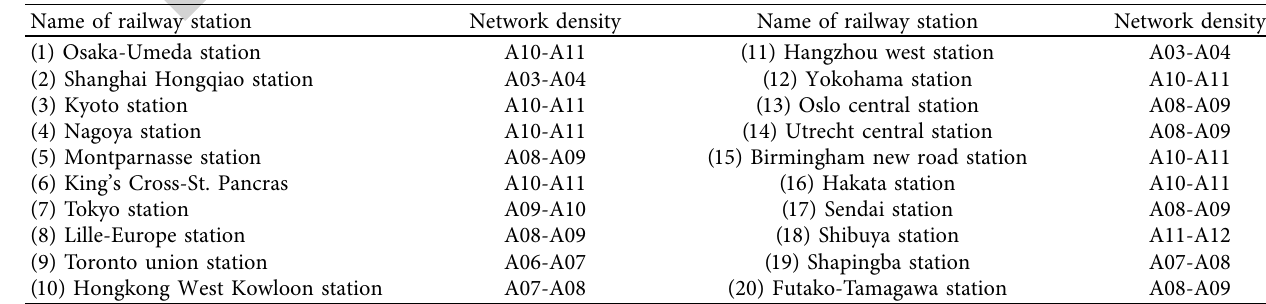
Table 5: Network density